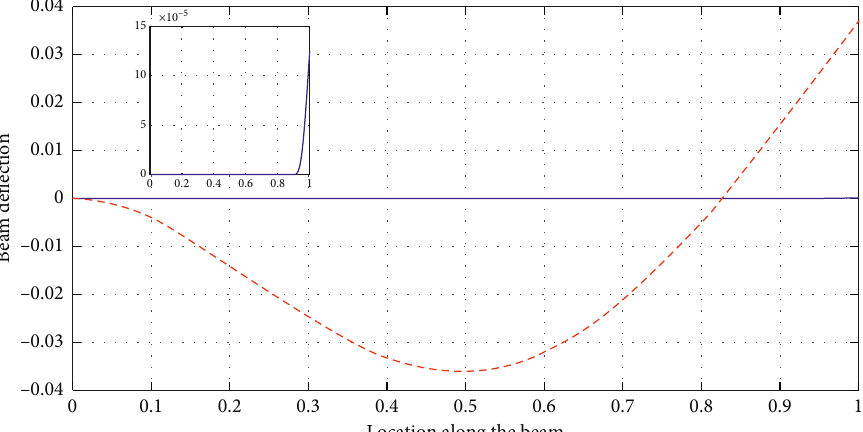
Figure 14: The steady-state deformed shape of a collocated controlled (solid line) and uncontrolled (dashed line) damped cantilever beam when c 1 � 0.1, c 2 � 0.001, ω � 20, x f � 1, x n � 0.3, x